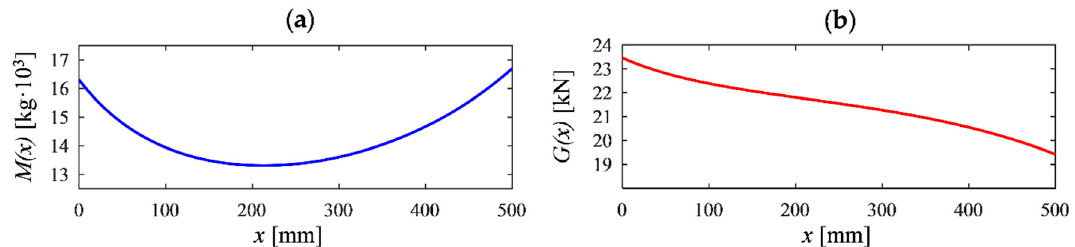
Figure 7. ( a ) Variation of the equivalent system’s mass as function of the piston position; ( b ) and variation of the gravitational load acting on the actuator as function of the piston position.